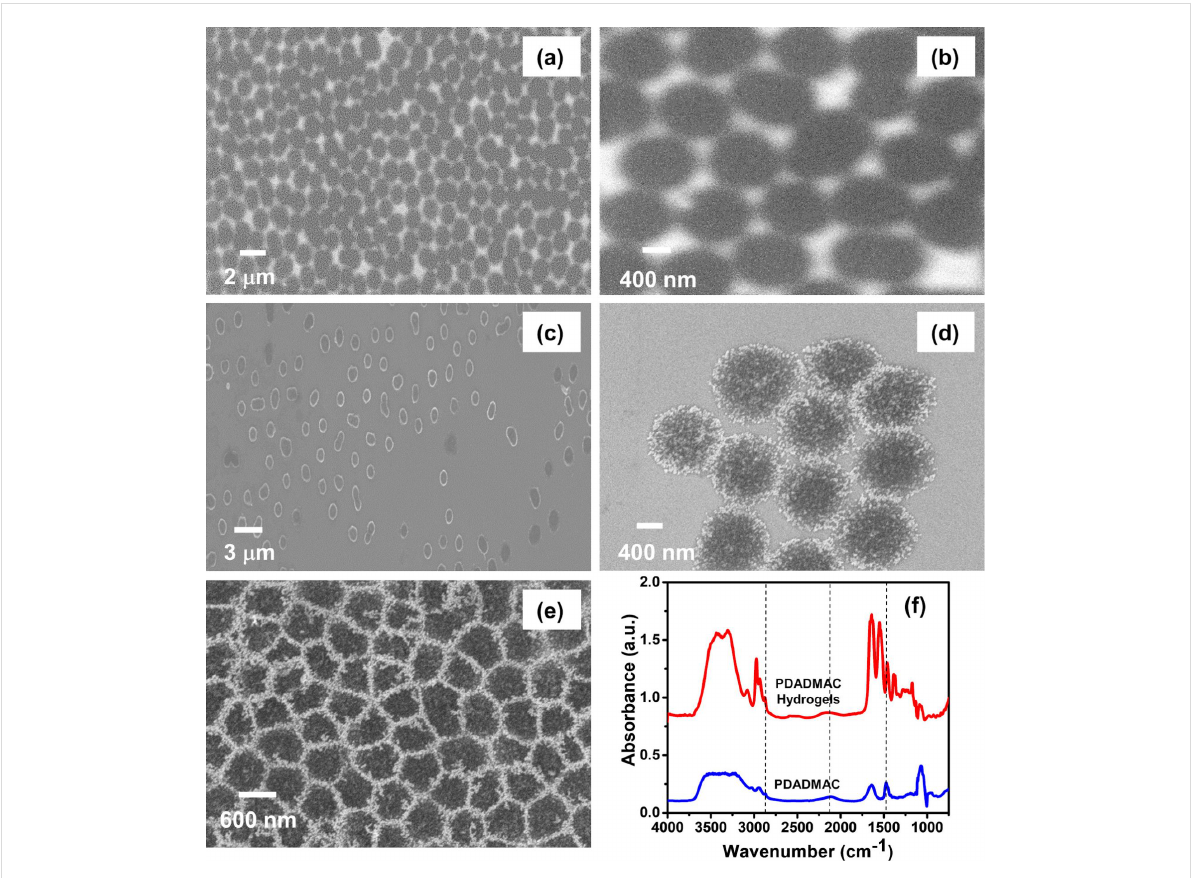
Figure 1: SEM images of (a) bare pNIPAM- co -AAc hydrogel particles (low magnification), (b) bare pNIPAM- co -AAc hydrogel particles (high magnifi- cation, ≈ 800 nm in diameter), (c) THPC gold seeds on hydrogel particles (low magnification), (d) THPC gold seeds on hydrogel particles (high magnifi- cation, ≈ 850 nm in diameter), (e) close packing of THPC gold-seeded hydrogel particles; and (f) Fourier transform infrared (FTIR) spectra of pure pDADMAC and pDADMAC-modified p(NIPAm- co -AAc) hydrogel